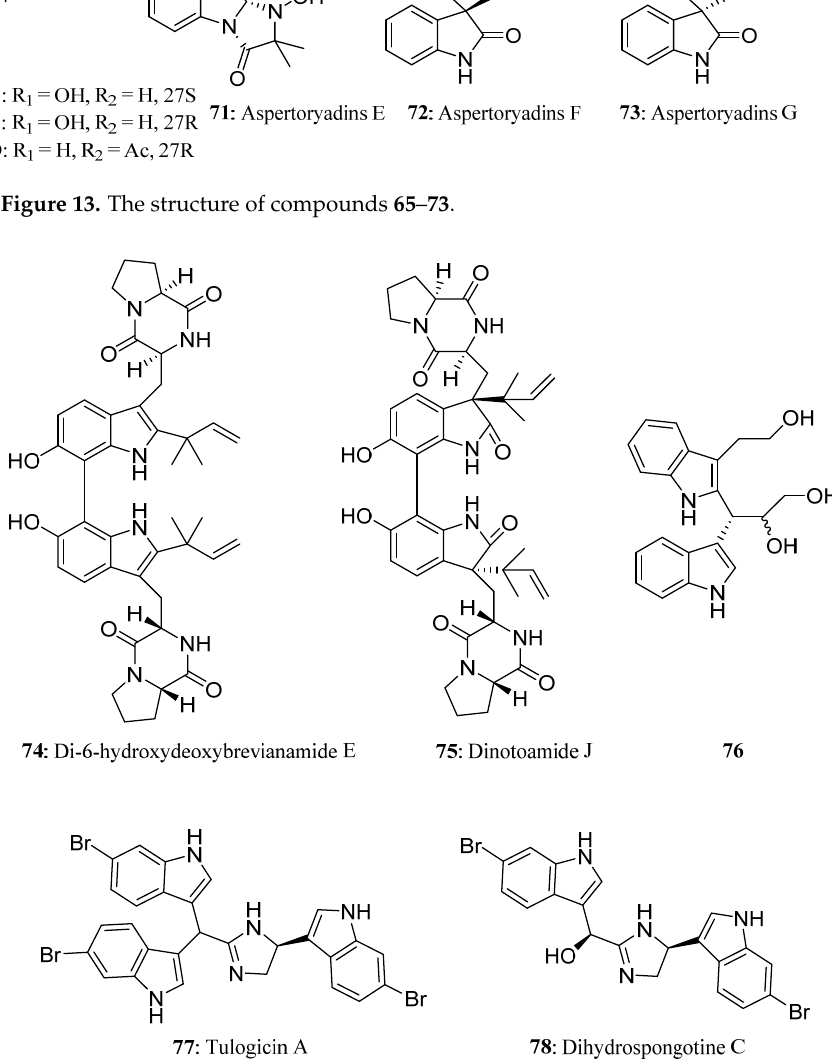
Figure 14. The structure of compounds 74 – 78 . Dionemycin ( 79 ) and 6-OMe-7 ′ ,7 ′′ -dichorochromopyrrolic acid ( 80 ), two novel chlo-